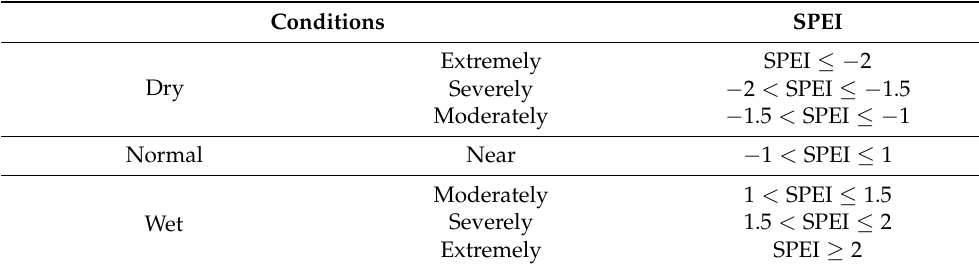
Table 2. SPEI scale [33,40,41]. Conditions